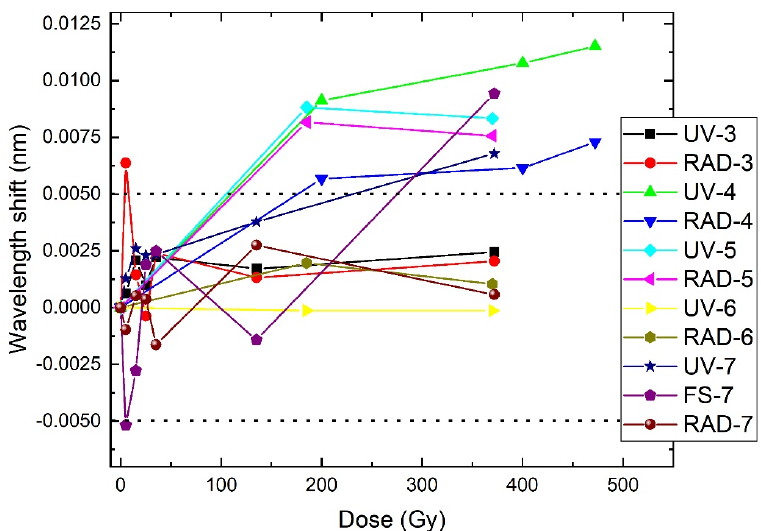
Figure 5. Radiation Induced Wavelength Shift as observed for test specimens exposed to proton radiation in tests Set 3–7. Left-side y axis lists Radiation Induced Shift (RIS) measured in nanometers as measured by the OGA. The approximate temperature shift that would be equivalent to the observed RIS if the FBGs were reacting only to a change in temperature is approximately 1 ͦ C for a wavelength shift of 0.01 nm. The dotted lines denote the OGA measuring uncertainty. shift of 0.01 nm. The dotted lines denote the OGA measuring